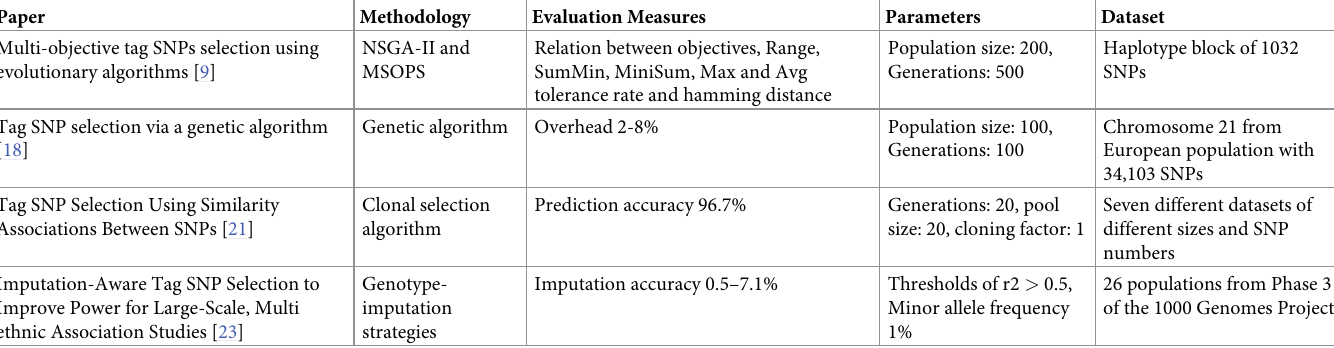
Table 1. Summary of the most relevant related